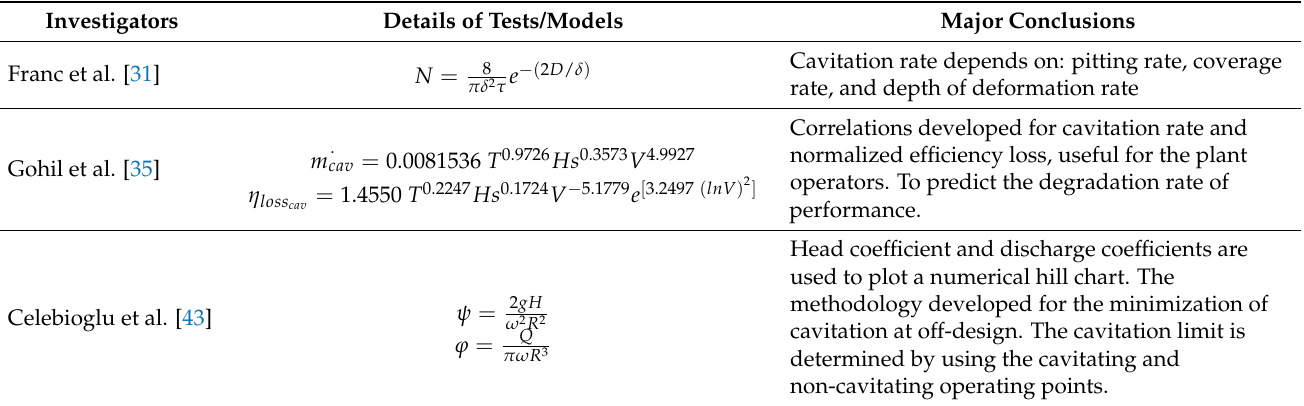
Figure 16. Hill chart for showing cavitation and non-cavitation operating points [43].